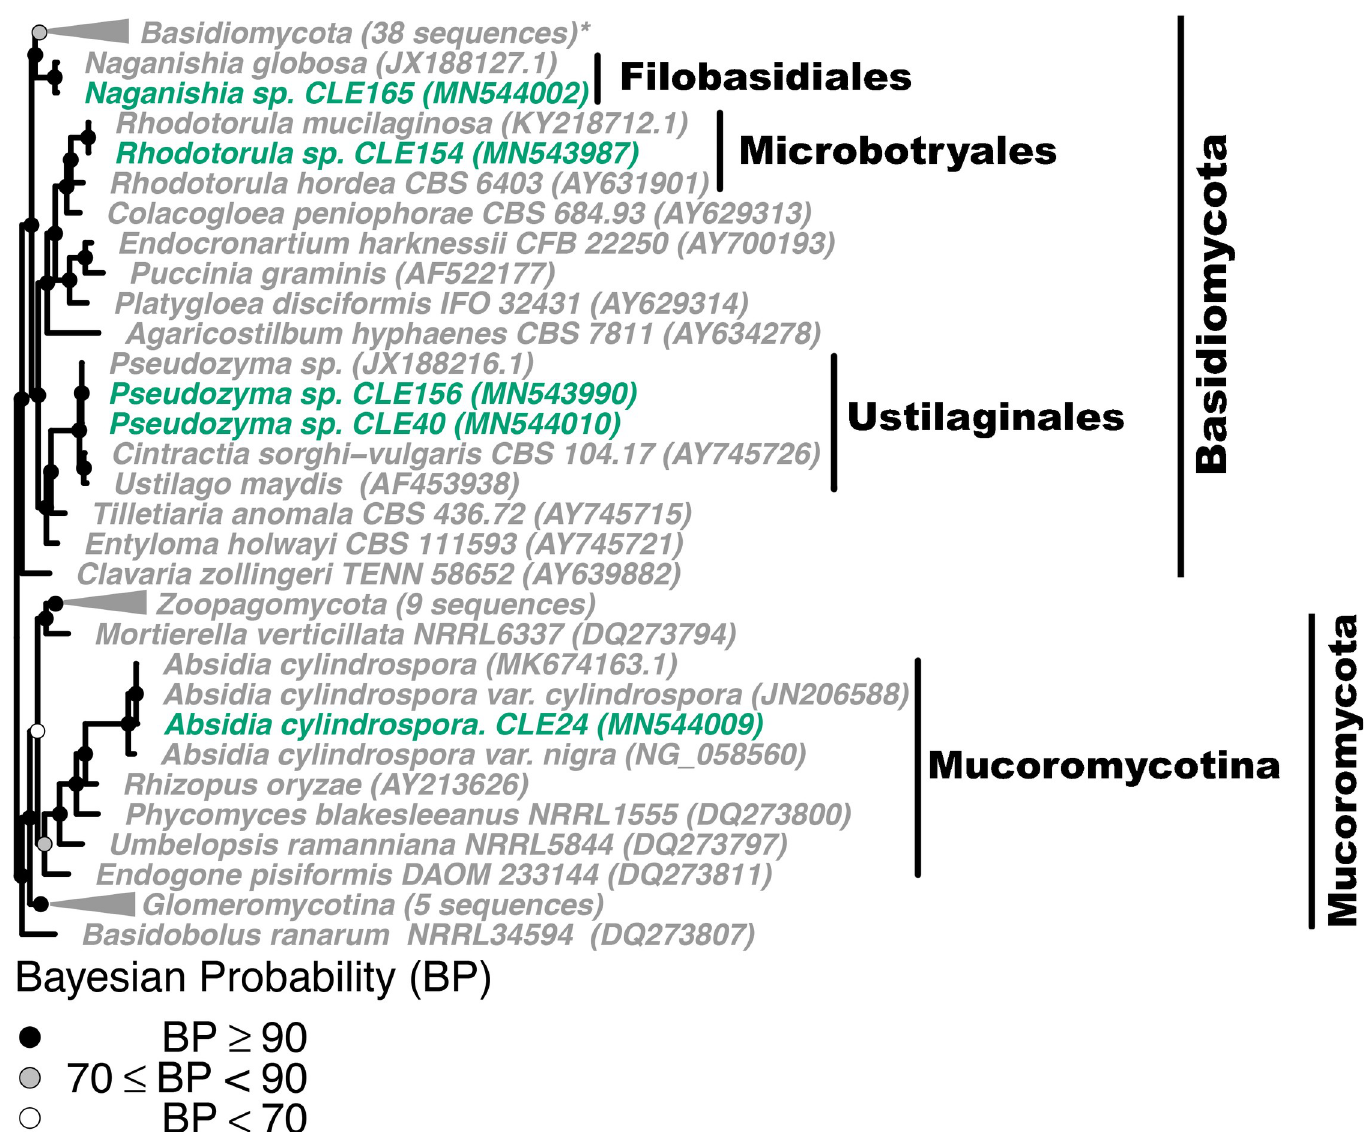
Fig 3. Phylogenetic placement of seagrass fungal isolates in the Basidiomycota and Mucoromycota. A molecular phylogeny of 28S rRNA genes for isolates in the Basidiomycota and Mucoromycota was constructed using Bayesian inference. This alignment was generated using MAFFT (v. 7.402) on the CIPRES Science Gateway web server, trimmed using trimAl (v.1.2) and a phylogenetic tree was inferred on the trimmed alignment with a GTR + I + G model using MrBayes (v. 3.2.2) [75–77,81]. Displayed at each node as a circle in the tree are the Bayesian posterior probabilities (e.g. a black circle represents probabilities greater or equal to 90%, a grey circle represents probabilities greater or equal to 70%, a white circle represents probabilities less than 70%). The names of fungi isolated from Z . marina are shown in green, fungi isolated from other seagrass species are shown in black, and all other fungi are shown in grey. For visualization purposes, selected clades have been collapsed and the number of sequences within that clade is indicated. Collapsed clades are shown in green if the majority of sequences in the clade are from isolates associated with Z . marina , black if the majority of isolates are from other seagrass species, and grey otherwise. Clade names that are followed by an asterisk contain sequences from multiple sources. An expanded version of this phylogeny can be found in S7 Fig. The GenBank accession numbers of the sequences used to build this phylogeny can be found in Tables 1 and